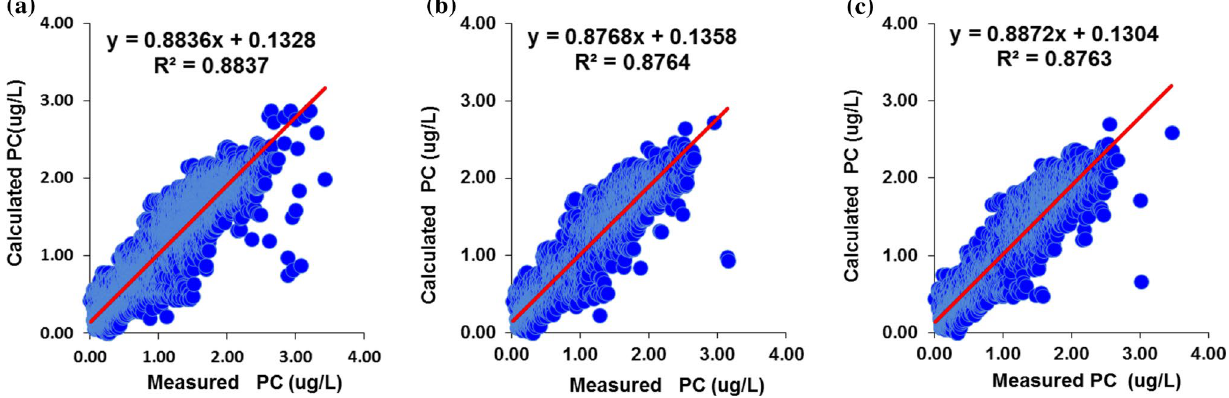
Fig. 6 Scatterplots of estimated versus measured values of PC for GEP (M1) model: a training, b validation and c test data—Station ID: